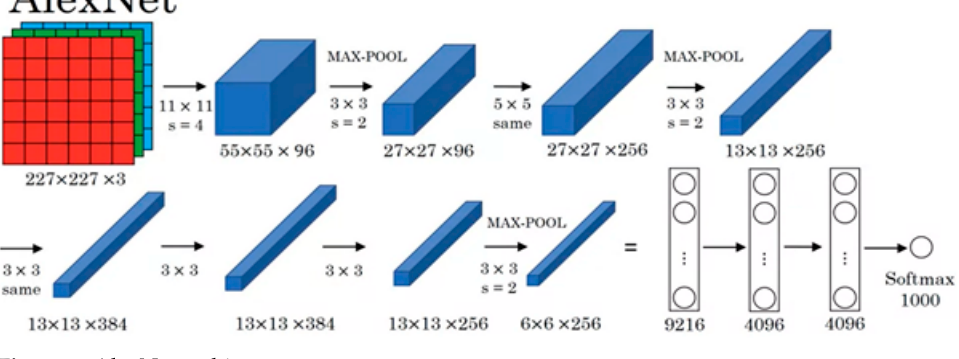
Figure 5. AlexNet architecture.